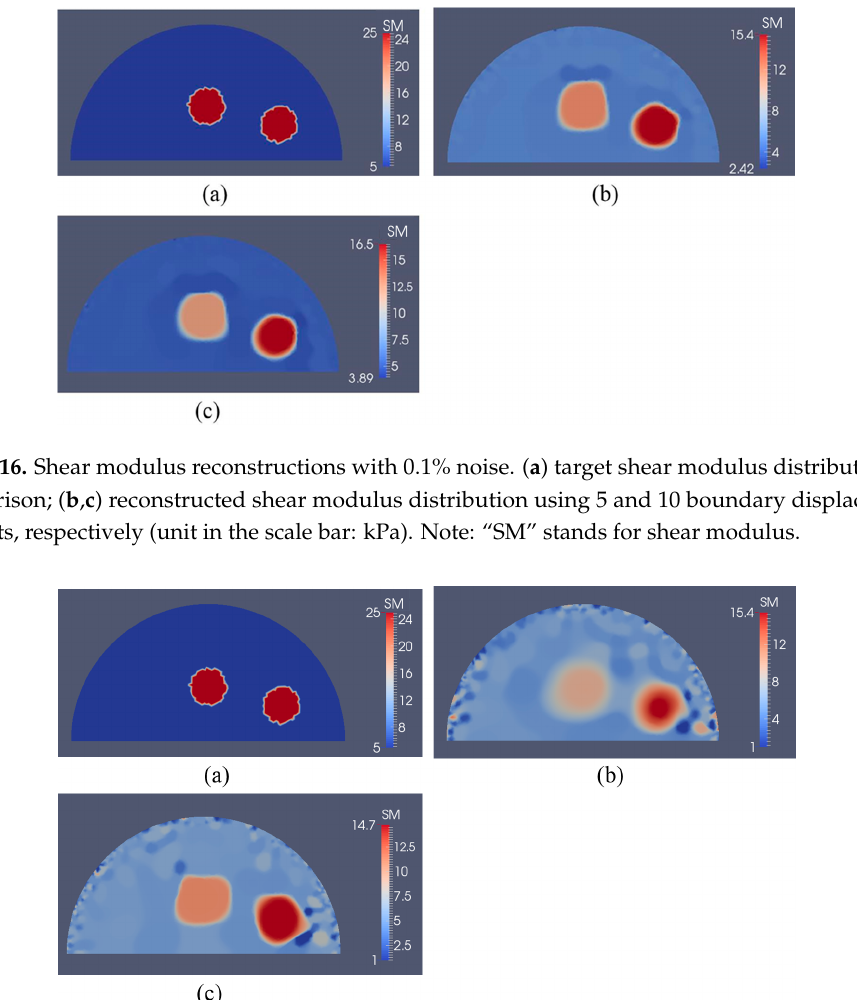
Figure 15. Problem domain with target shear modulus distribution is defined in the first column with varying shear modulus values in the inclusion from 7.5 kPa (top row) to 100 kPa (bottom row) to test the feasibility range of stiffness detection. Column 2 and column 3 represent the shear modulus reconstructions with 5 and 10 boundary displacement data sets, respectively, using 1% noise.